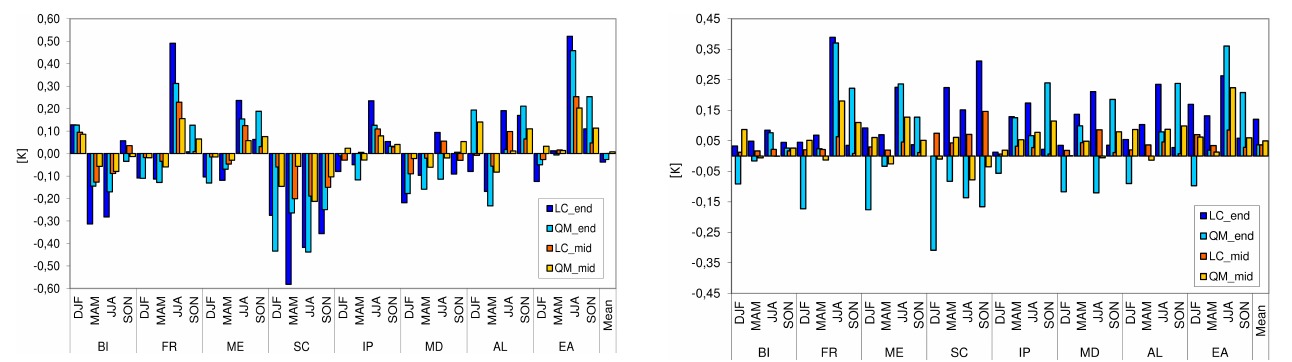
Figure 8. Estimated errors in the multi-model standard deviation of the temperature CCS due to intensity-dependent model errors. The reference period is 1971–2000. The orange colors refer to CCSs until the mid-21st century (2021–2050), the blue colors until the end of the 21st century (2070–2099). Light colors correspond to the estimation of the error by QM, dark colors to